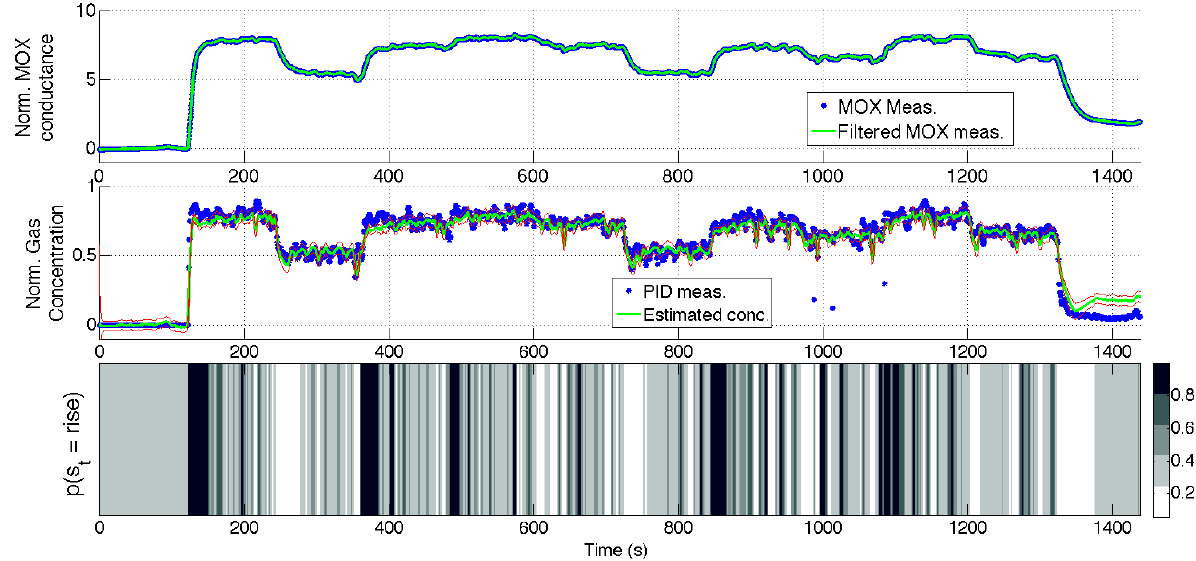
Figure 13. aSLDS inference results for an experiment of dataset Random Stairway . ( Top ) MOX measurements, ( Middle ) Gas concentration, ( Bottom ) Sensor phase probability